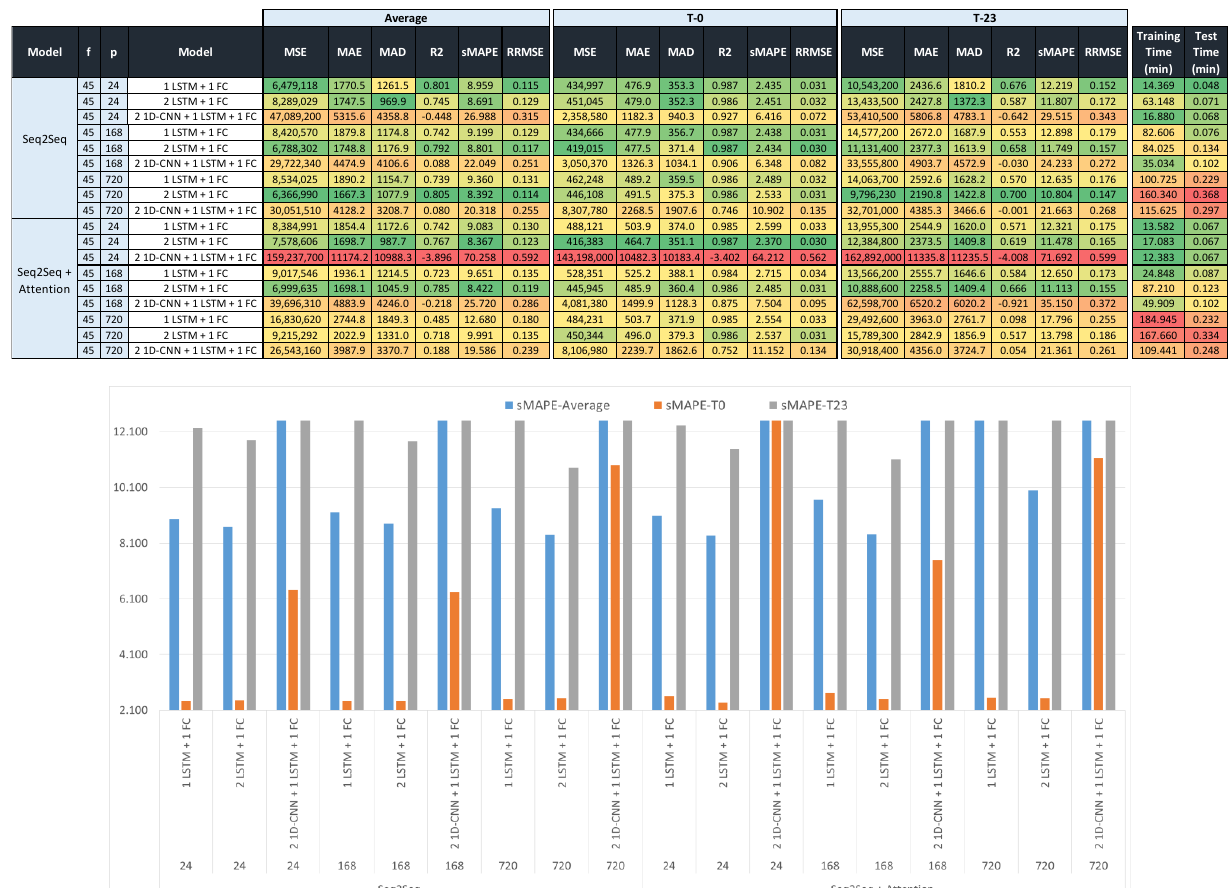
Figure 6. ( Upper section ): forecast metrics for the average, first (T-0), and last (T-23) predicted time-slots using Seq2seq with and without an attention mechanism. The table is color-coded along columns with colors between red and green corresponding to the worst and best results, respectively. ( Lower section ): bar chart for sMAPE metrics for some of the best performing models from the upper table.